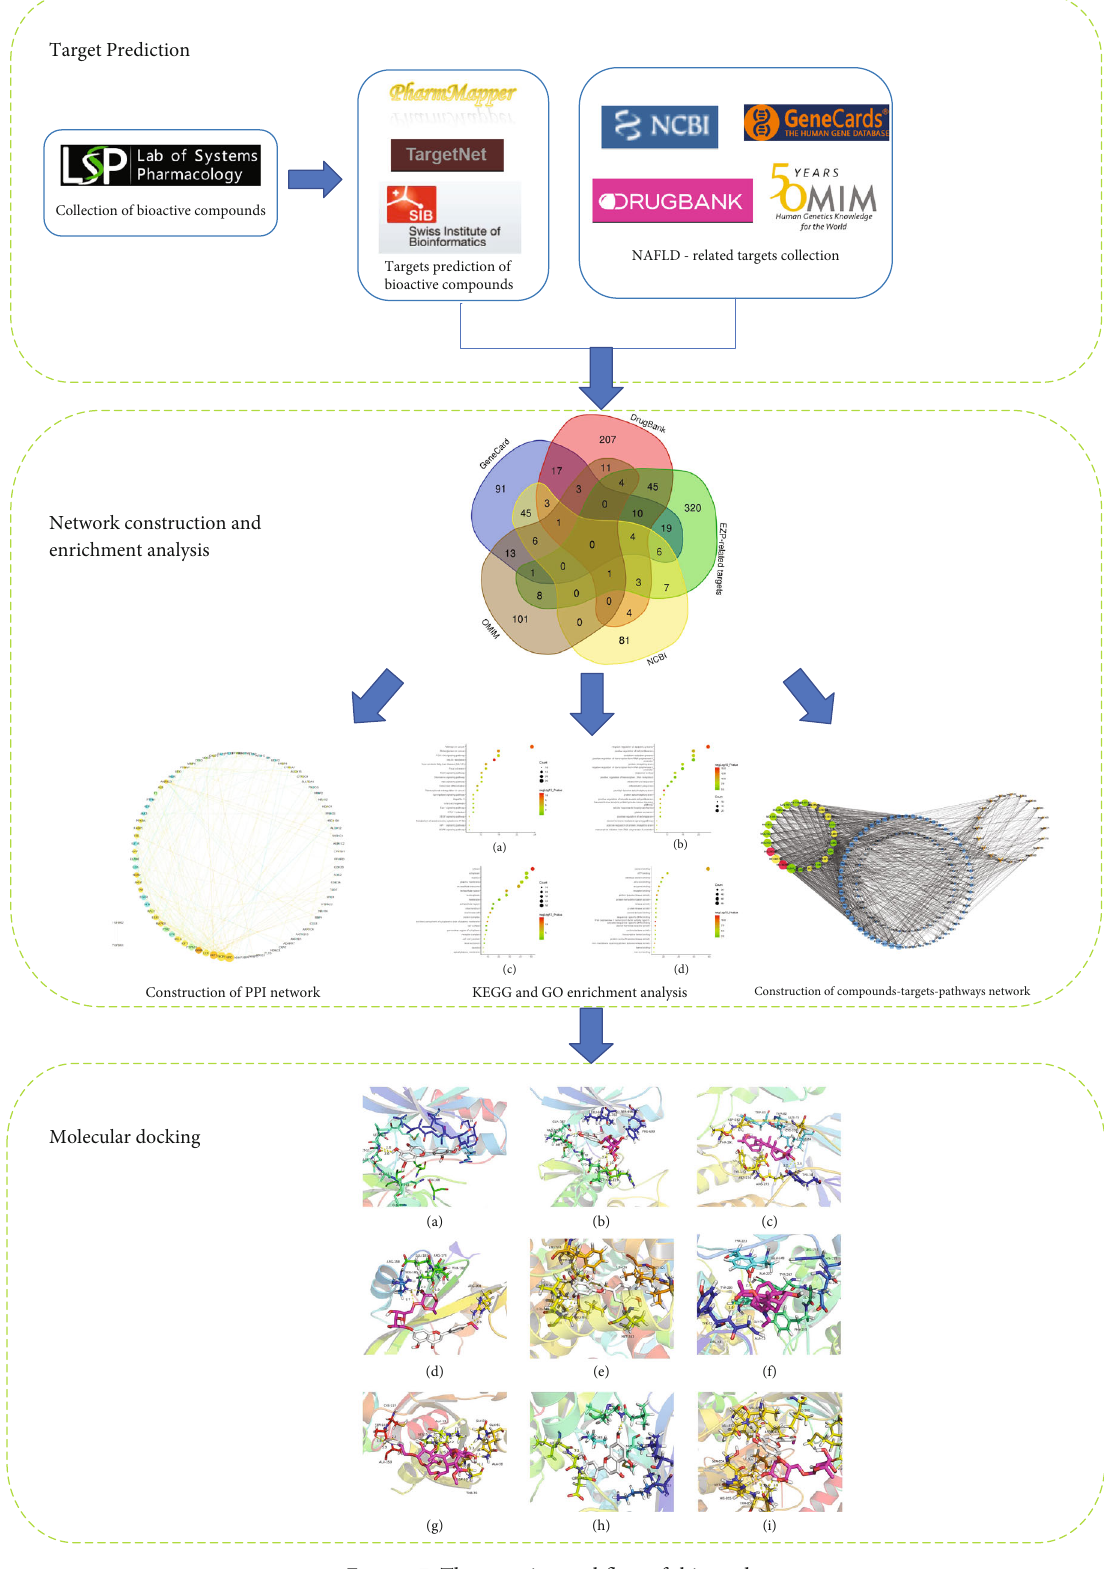
Figure 7: The experimental fl ow of this